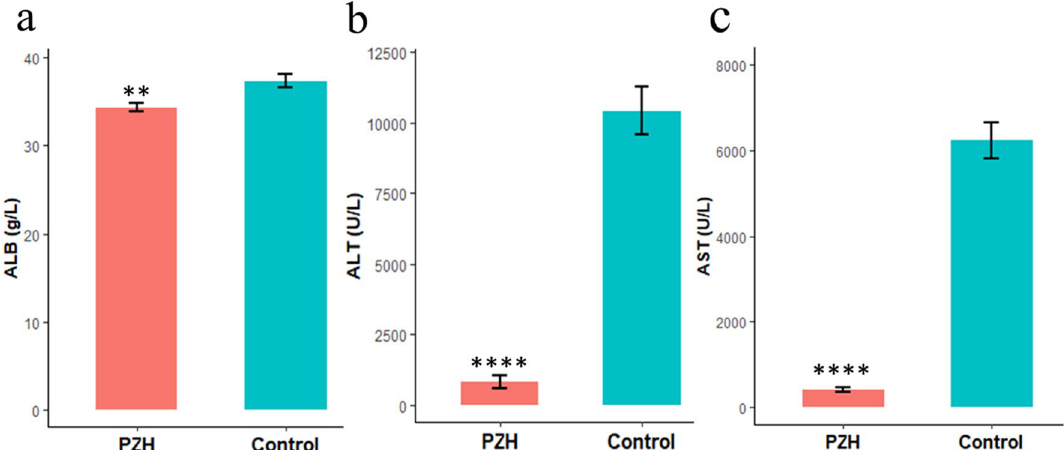
Figure 1. Liver function serum biochemical indices at the time point of eighth week. ( a ) Serum ALB indices of the PZH and control groups. ( b ) Serum ALT indices of the PZH and control groups. ( c ) Serum AST indices of the PZH and control groups. Mean ± SE. **P < 0.01 , ****P < 1.0 × 10 –4 . n =